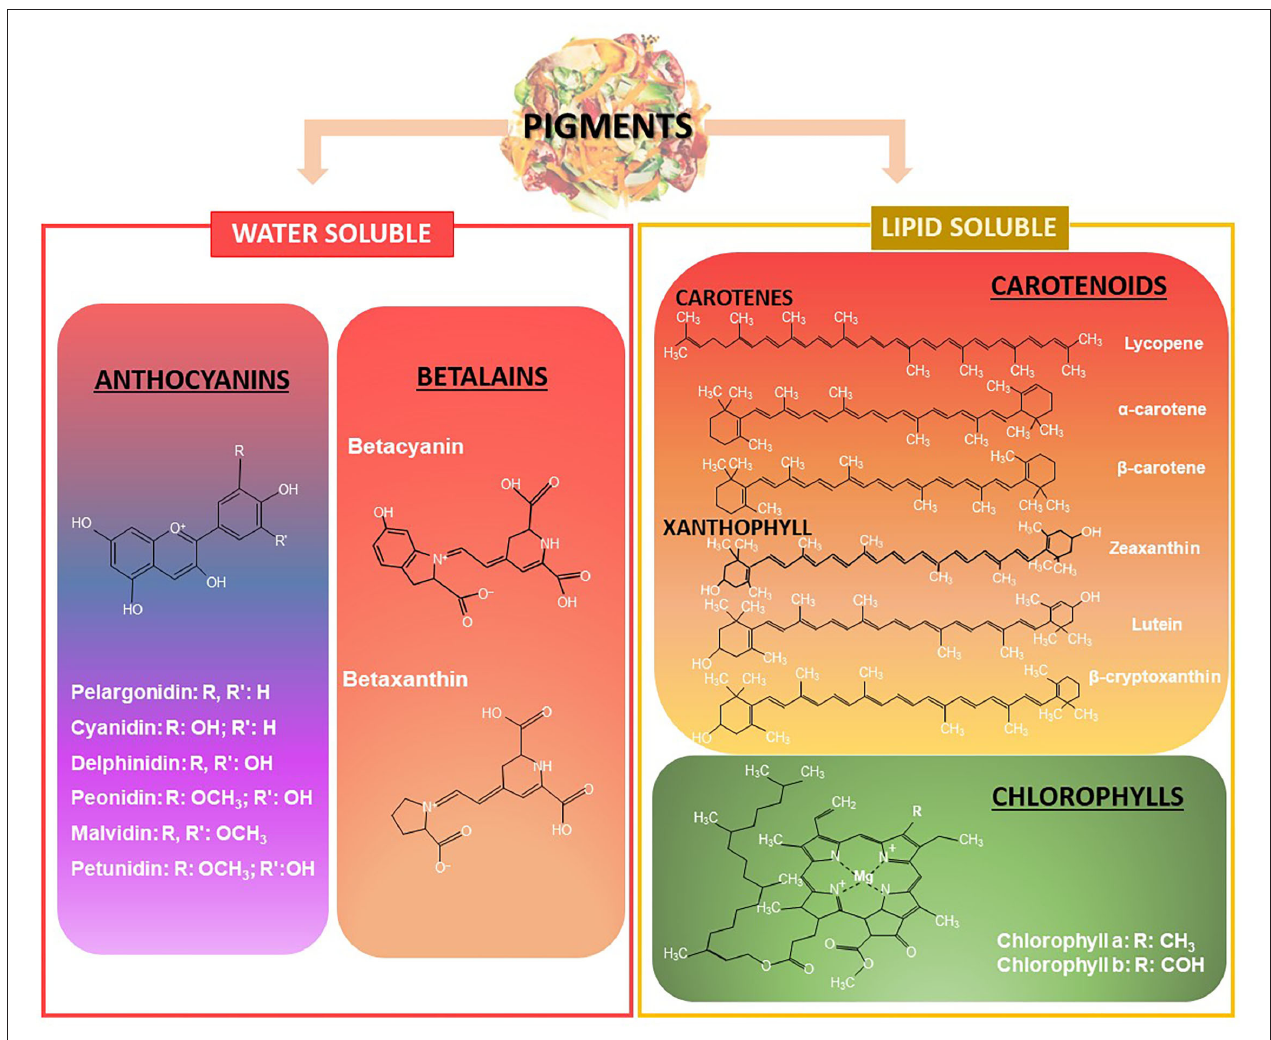
FIGURE 3 | Representative chemical structures from the most common types of natural pigments present in food wastes and losses.